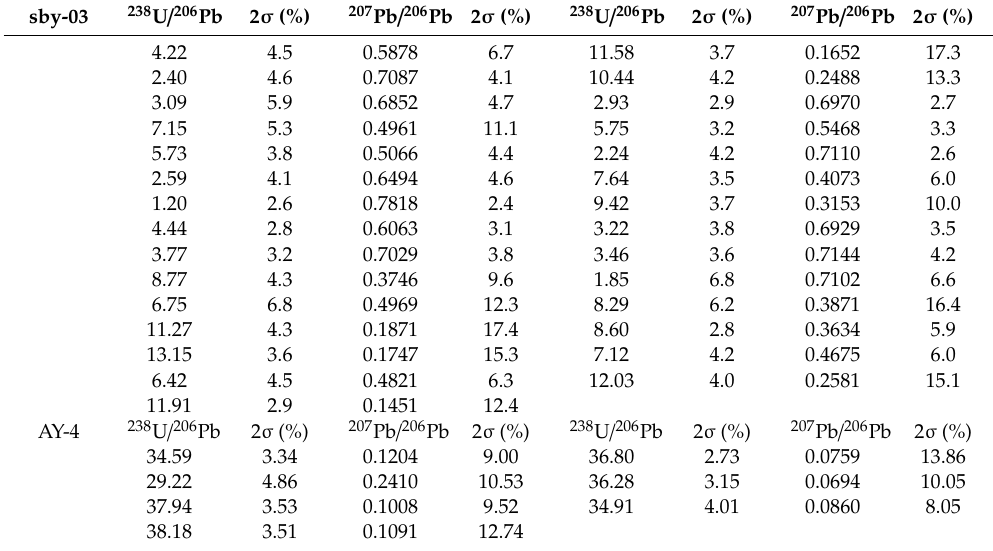
Table 6. U–Pb isotopic data for cassiterite (sby-03 from the Sanbao deposit; AY-4 in-house external